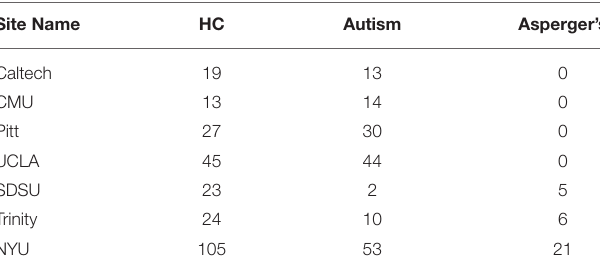
TABLE 11 | Number of subjects provided by each site in the ASD sample.